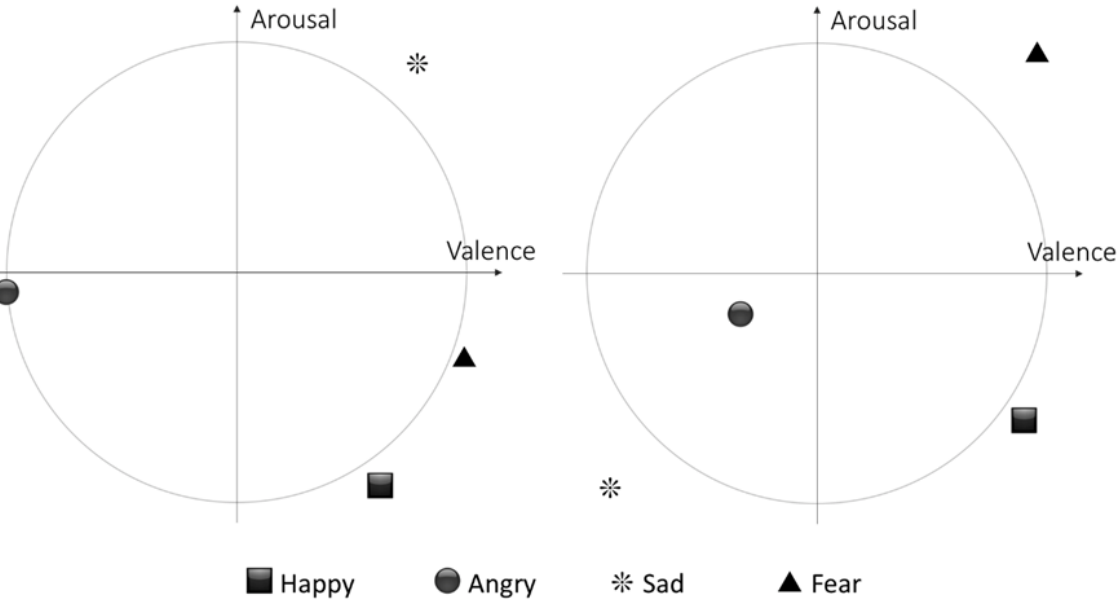
Figure 4. Session 1 and post session 4 normalized averaged (centroids) arousal and valence values in NM1 condition for the four emotional stimuli considered.